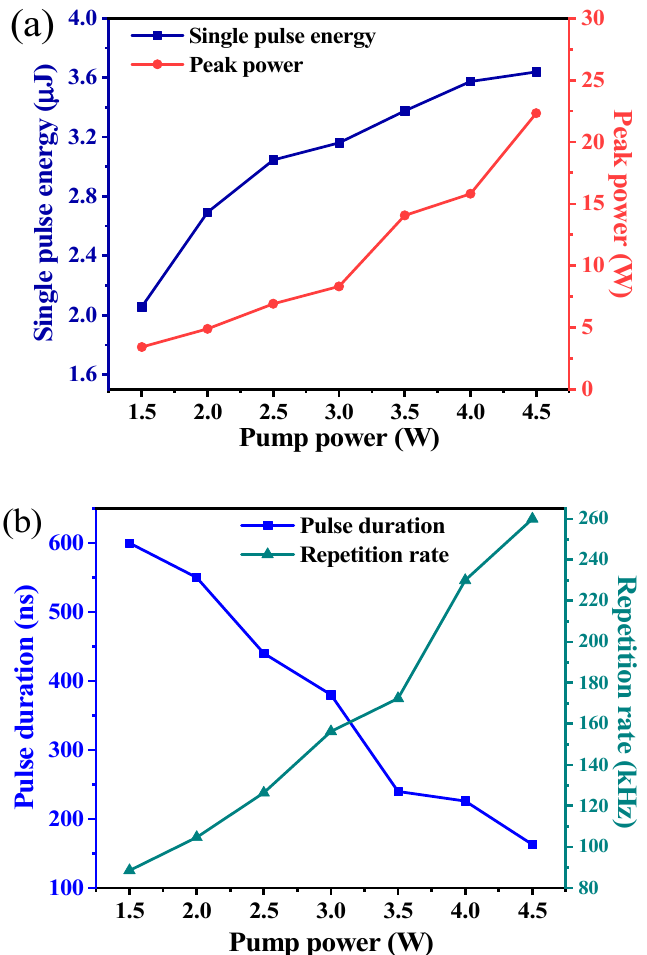
Figure 7. ( a ) Single pulse energy and peak power versus pump power. ( b ) Pulse duration and repetition rate versus the pump power.